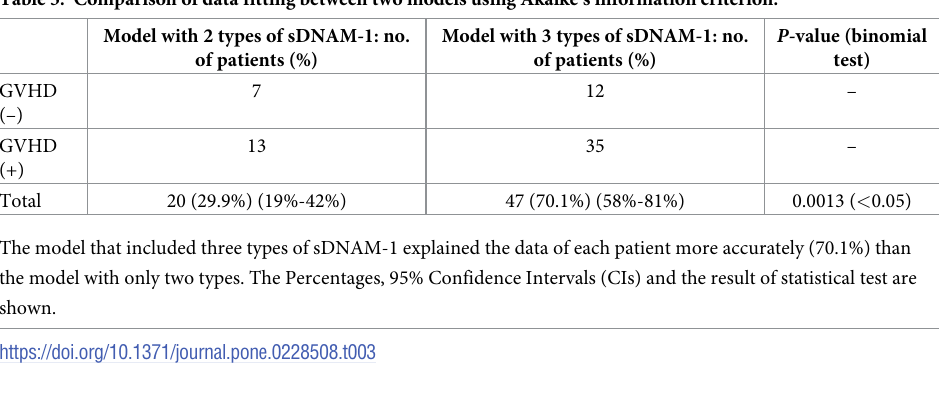
P -value (binomial test)